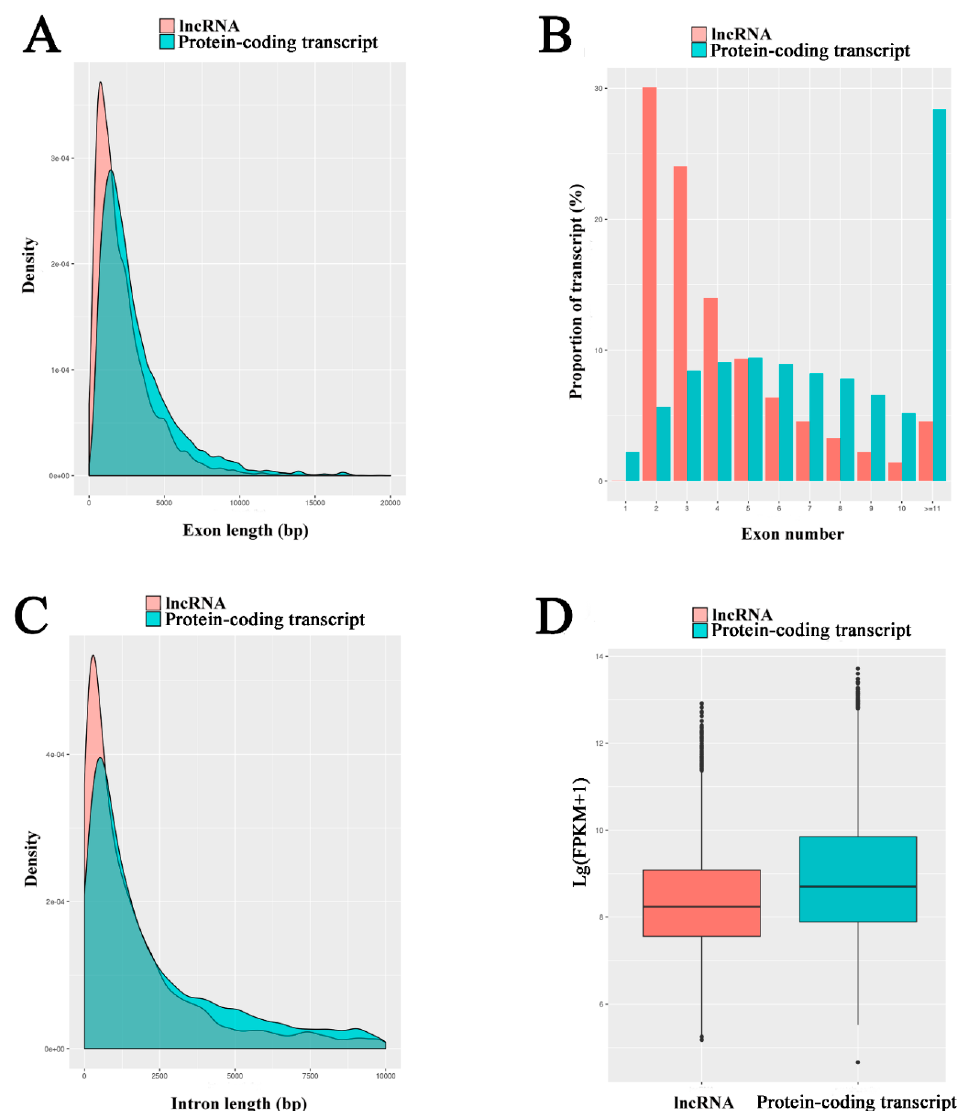
Figure 2. Properties of A. m. ligustica long non-coding RNAs (lncRNAs). ( A ) exon size distributions for lncRNAs and protein-coding transcripts. ( B ) number of exons per lncRNAs and protein-coding transcripts. ( C ) intron size distributions for lncRNAs and protein-coding transcripts. ( D ) expression levels of lncRNAs and protein-coding transcripts.